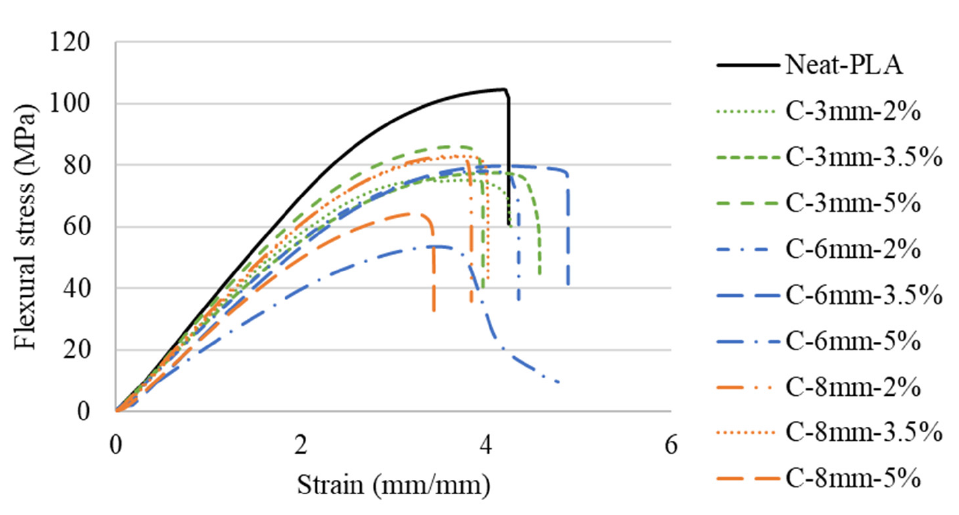
Figure 8. Representative flexural stress–strain curves.